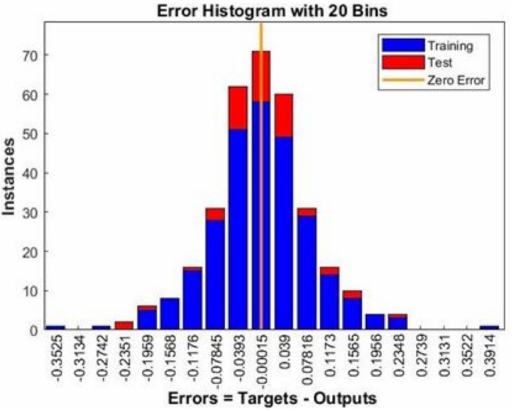
Figure 9. Distribution of the model errors.